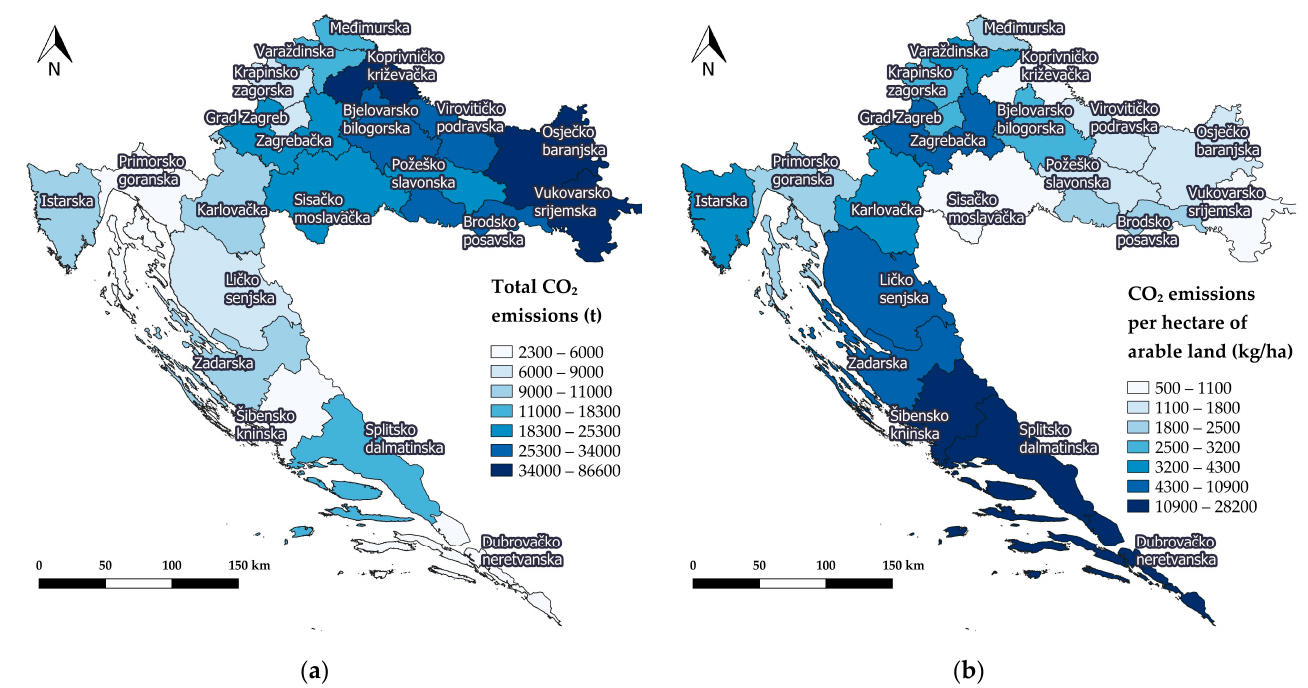
Figure 5. Spatial distribution of total carbon dioxide (CO 2 ) emissions ( a ) and spatial distribution of CO 2 emissions per hectare of arable land ( b ).